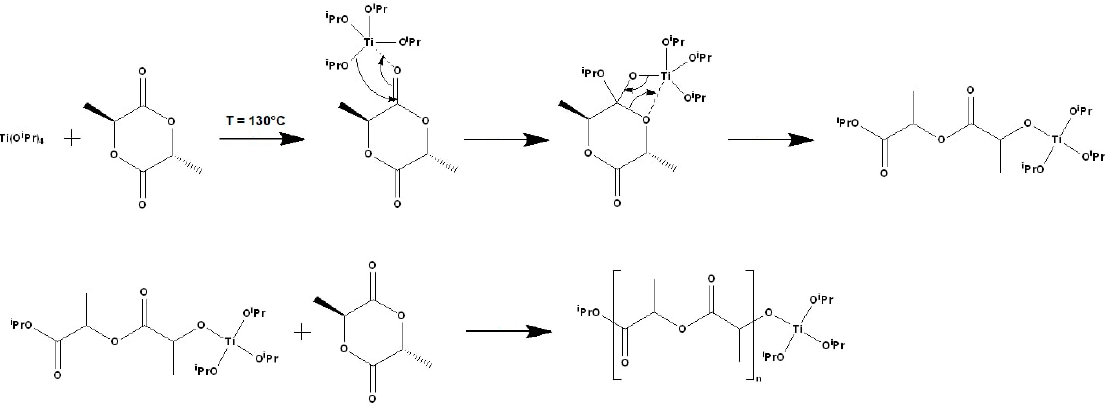
Figure 1. Proposed scheme for the polymerization of lactide Temperature of reaction—130 °C. i Pr = isopropyl. The process was carried out at different molar ratios of lactide (LA) and titanium isopropoxide (TTIP). The resulting products were precipitated with ethanol and dried in a vacuum oven to constant weight. The molecular weight characteristics of PLA are shown in Table